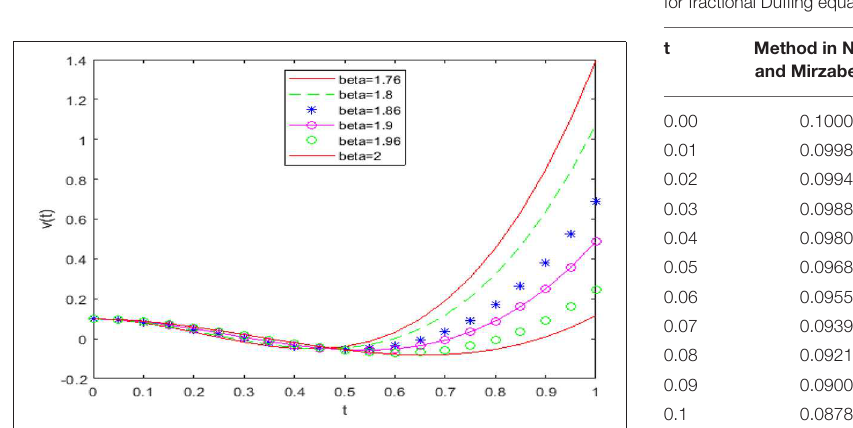
FIGURE 4 | Numerical solutions at β 1.76, 1.8, 1.86, 1.9, 1.96, and 2 for = case 2 at e 1 and f 1. = =